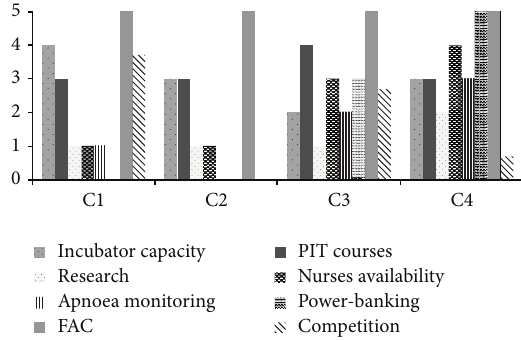
Figure 11: Concerns remedy implementation degrees. Scores: poor (0) to good